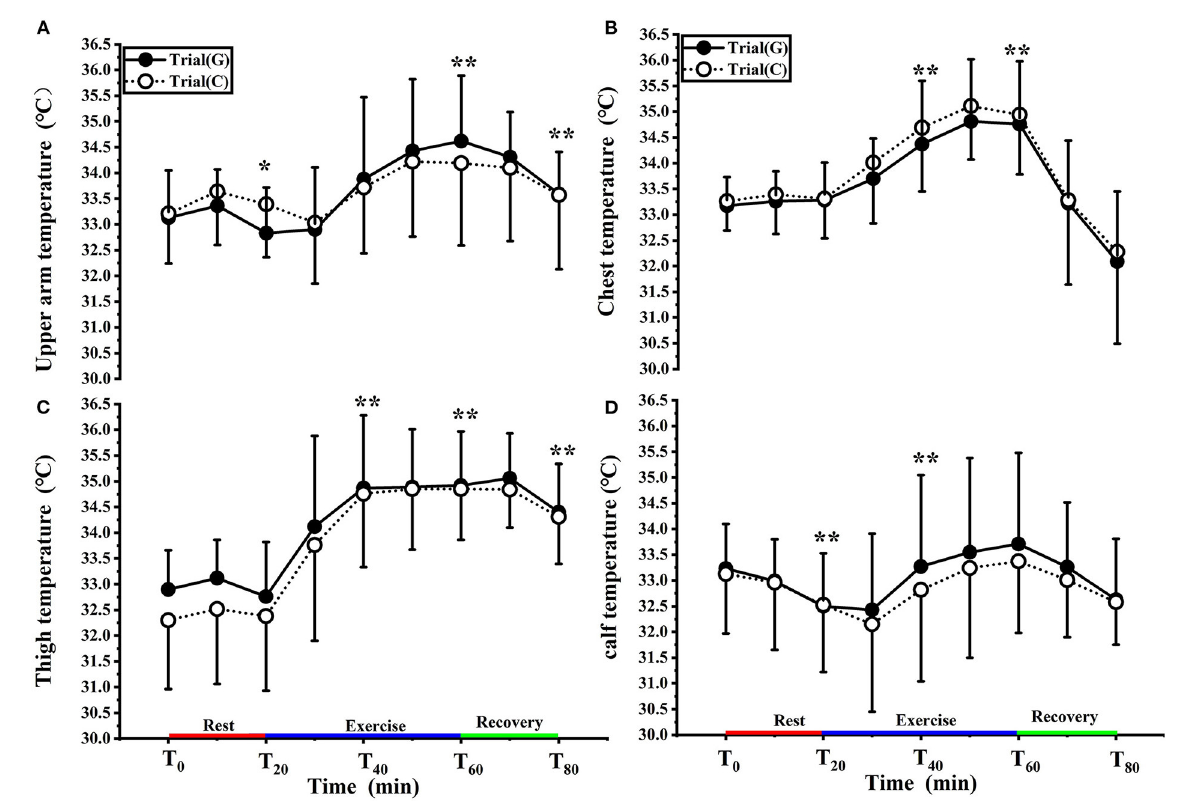
FIGURE4 Change in upper arm (A) , chest (B ), thigh (C) , calf (D) temperature in trial G (black) and trial C (white). Values are means ± SD. Bars represent standard deviations, * P < 0.05, ** P < 0.01, significant difference compared to T 0 .